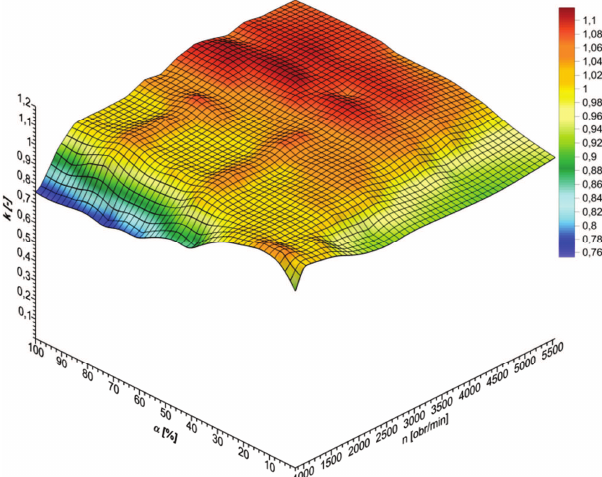
Fig. 4. „Map” of the k correction